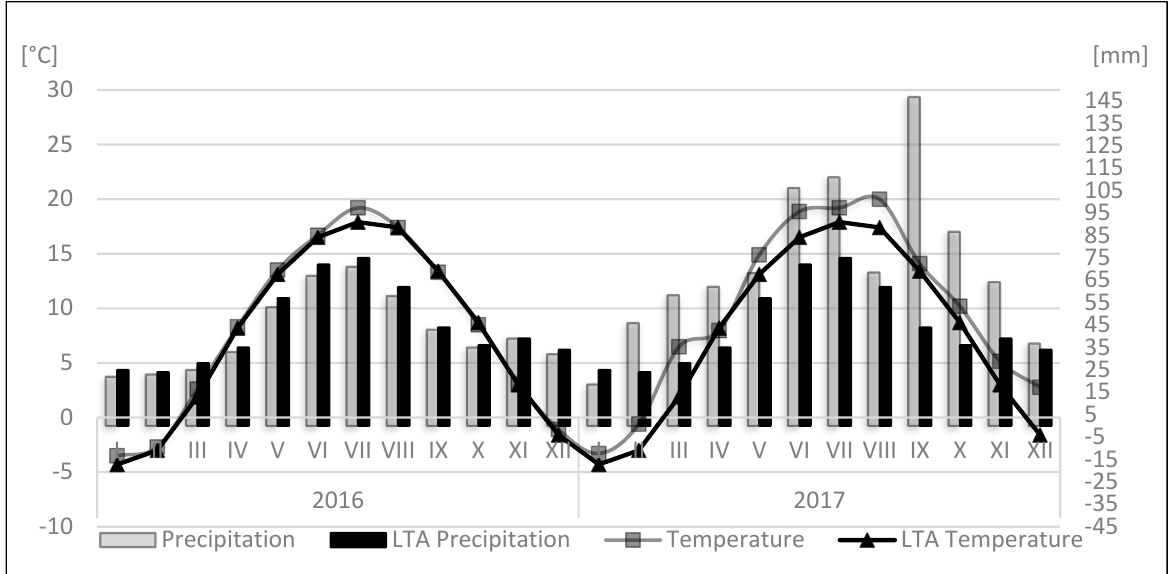
Figure 1. Data on average temperatures and rainfall at the experimental site in 2016 and 2017 growing seasons. LTA, the long-term average for years 1982 – 2012. Table 6. The influence of the growing season on the concentrations of biologically active compounds